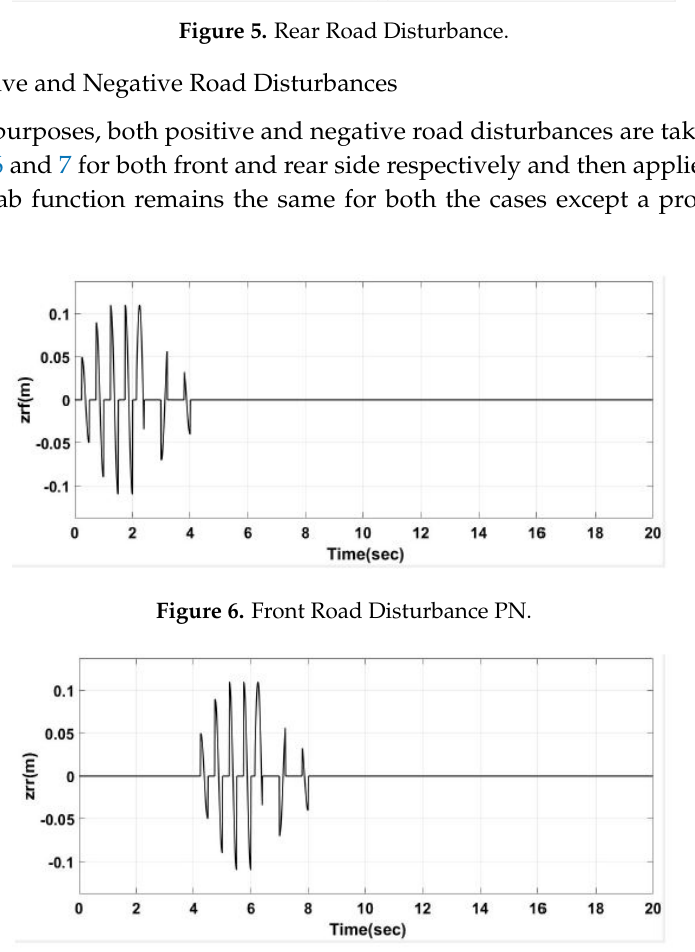
Figure 7. Rear Road Disturbance